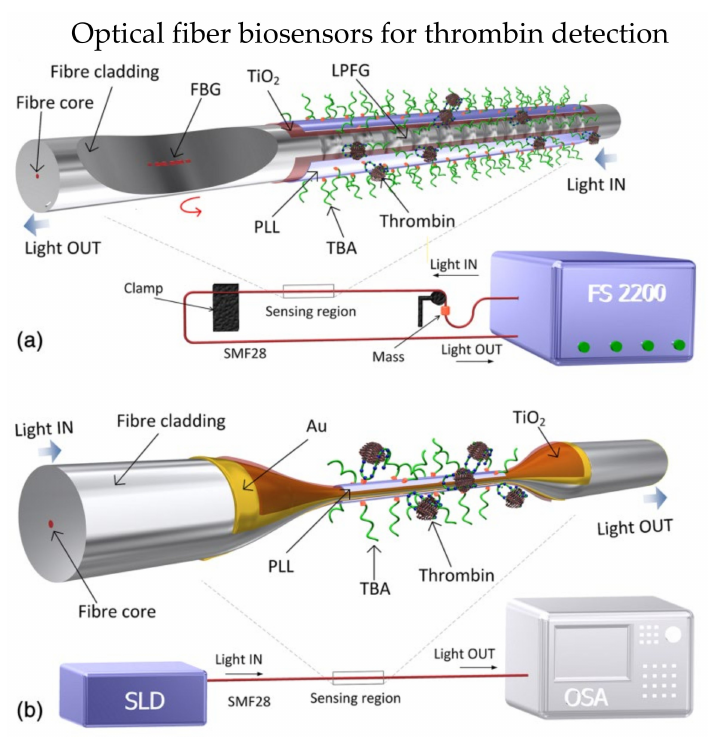
Figure 4. Schemes of biosensor for thrombin detection: ( a ) A layer of TiO 2 was coated on the long period fiber grating (LPFG), an FBG was inscribed on the same fiber; ( b ) Au and TiO 2 were coated on the etched single-mode fiber (SMF) to excite SPR. Reprinted with permission from Ref. [46]. Copyright 2016,